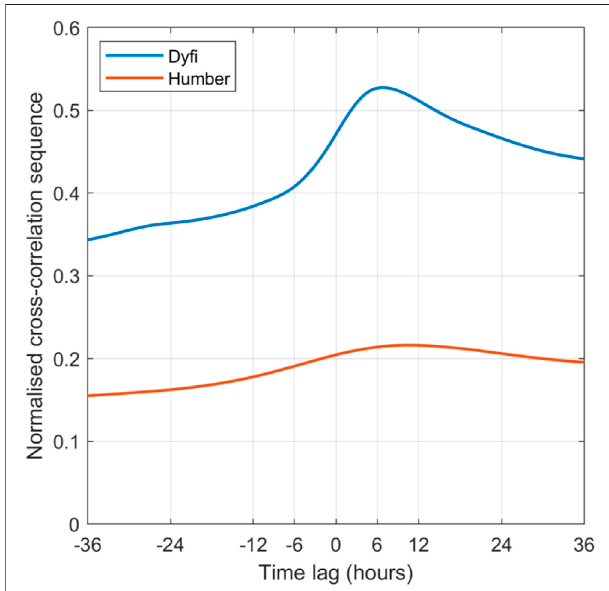
FIGURE 7 | Cross-correlation results for river fl ow versus storm surge, using all 15-min data, for the Dy fi and Humber.